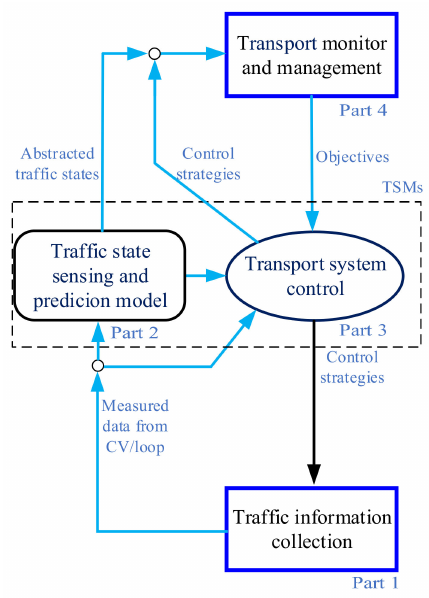
Figure 1. Architecture of Intelligent Transportation